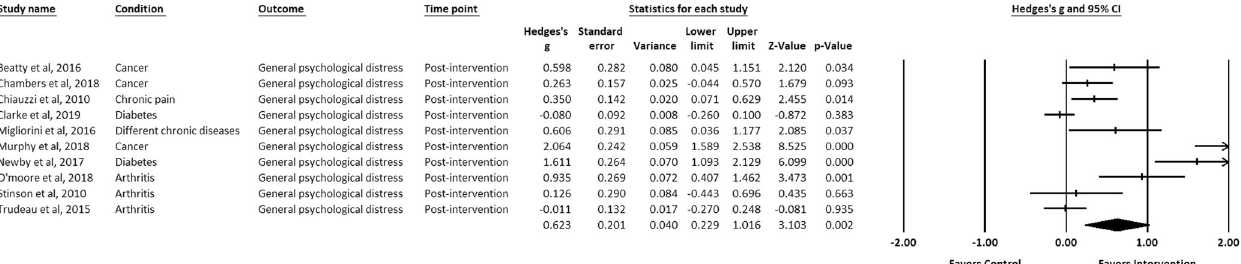
Fig. 4 Forest plot for effect sizes of IM-CBT on general psychological distress at post-intervention.